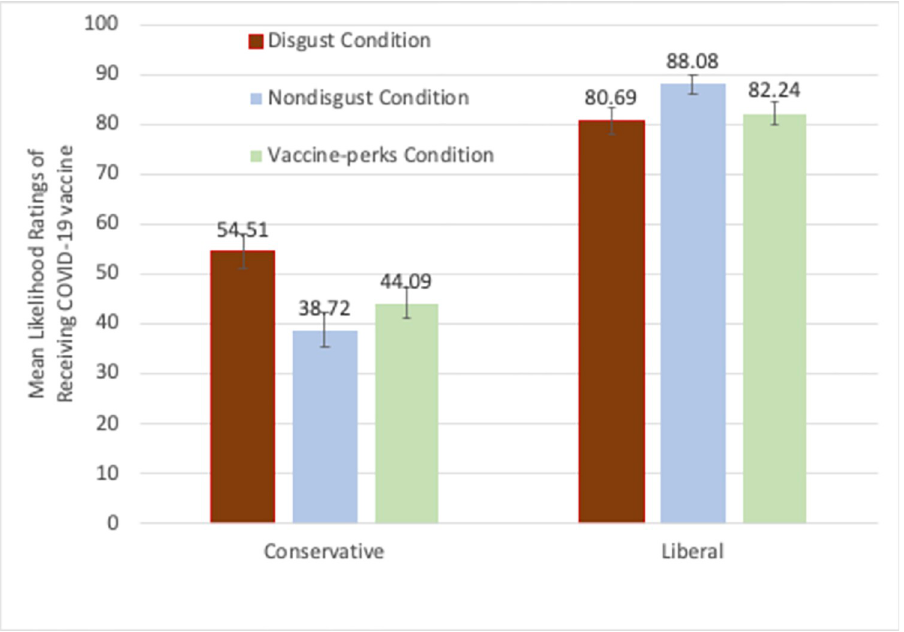
Fig 3. Mean Likelihood ratings of receiving COVID-19 vaccine by the unvaccinated conservative and the liberal participants in the disgust, non-disgust, and the vaccine-perks conditions in study 2. (Note: Error bars show standard